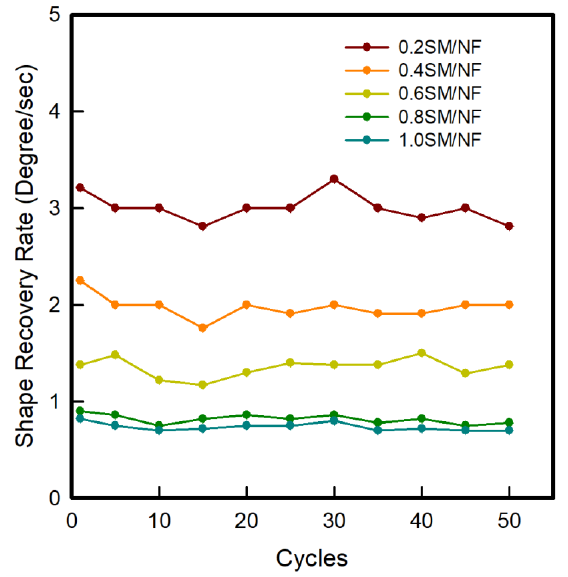
Figure 4. Shape recovery rate of 3D-printed sinusoidal sample/nylon composite with various thicknesses and various cycles.